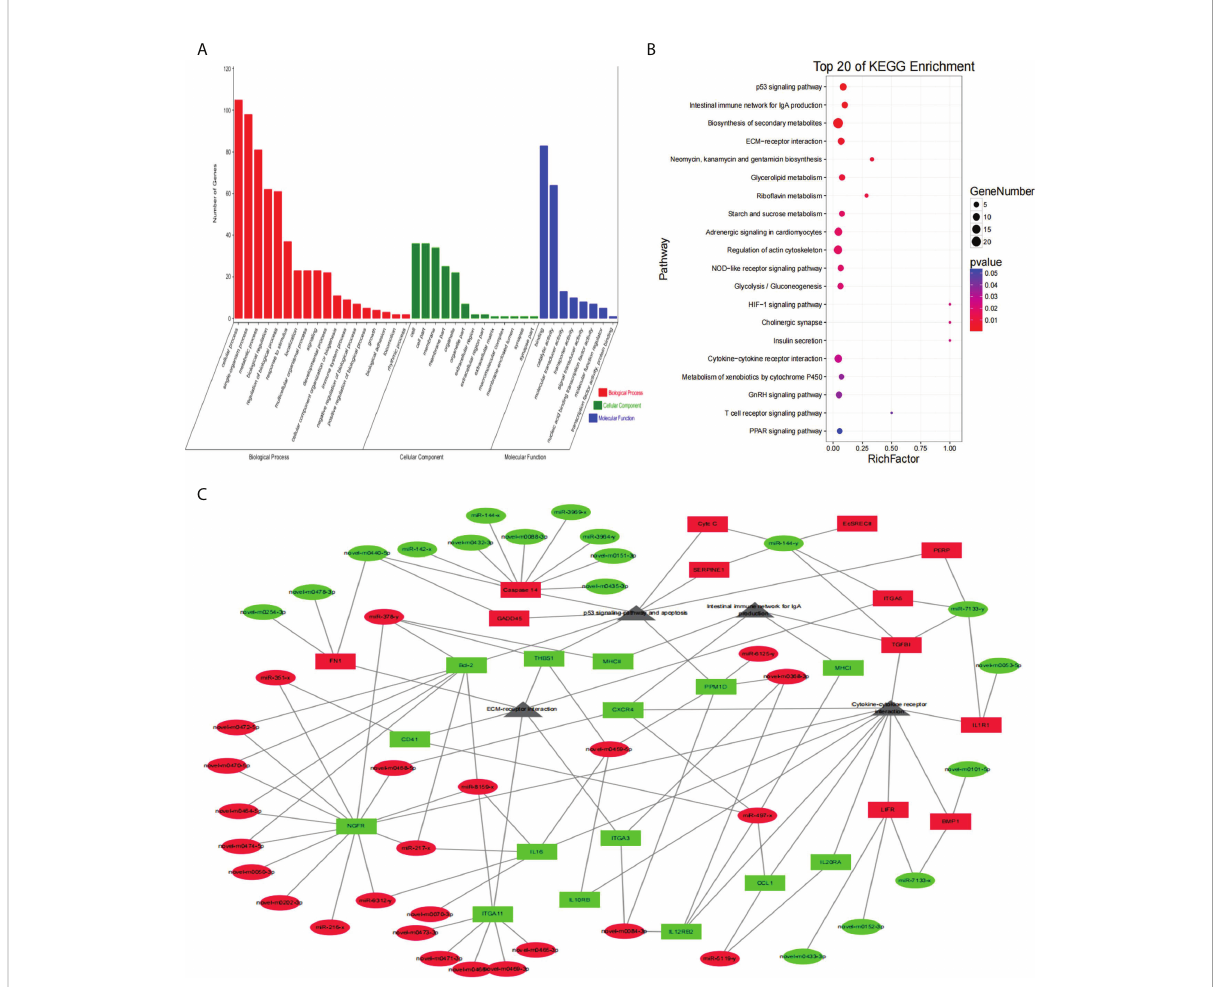
FIGURE 5 Functional annotation analysis of target DEGs of DEMs and network for miRNA-mRNA-Pathway interaction. (A) GO enrichment analysis of target DEGs of DEMs. The abscissa indicates 3 ontologies (molecular function, cellular component and biological process) with 39 GO terms, the vertical coordinate indicates the genes count. (B) KEGG pathway analysis of target DEGs of DEMs. The abscissa represents the ratio of the number of genes in the DEGs and the vertical coordinate represents the pathways. The redder bubble indicates more obvious enrichment, with smaller P-value . The larger bubble contains more target genes. (C) Network diagram for miRNA-mRNA-Pathway interaction. Ellipse represents miRNA, Round Rectangle represents mRNA, Triangle represents signaling pathway; Red color indicates up-regulated, blue color indicates down- regulated, gray color indicates no difference. DEGs, differentially expressed genes; DEMs, differentially expressed miRNAs; GO, Gene Ontology; KEGG, Kyoto Encyclopedia of Genes and